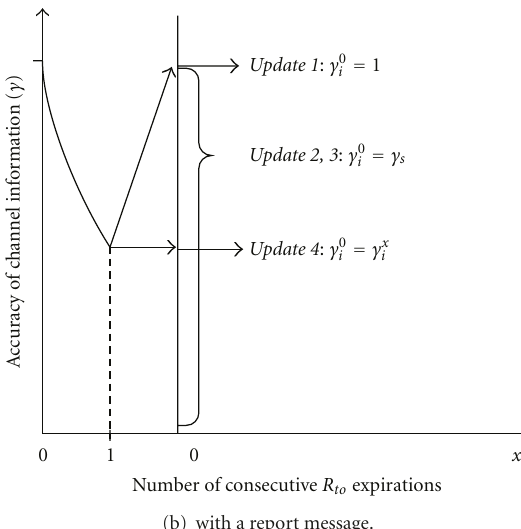
Figure 4: Calculation of the accuracy index of the i th channel.